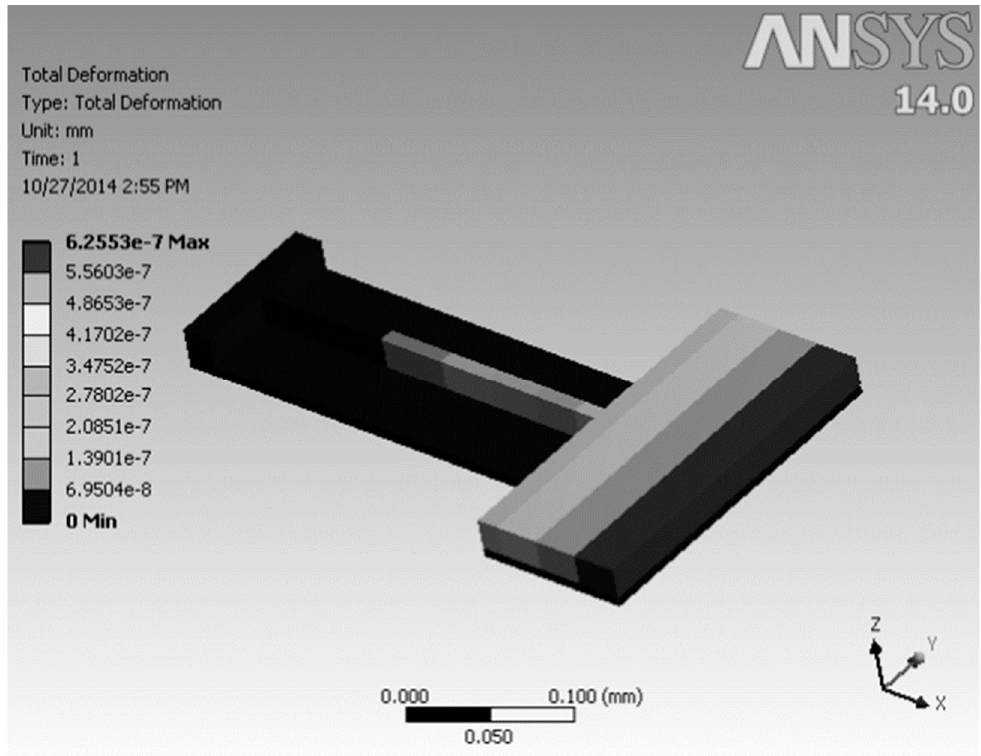
Figure 6. Static structure the analysis of the optimized capacitor.